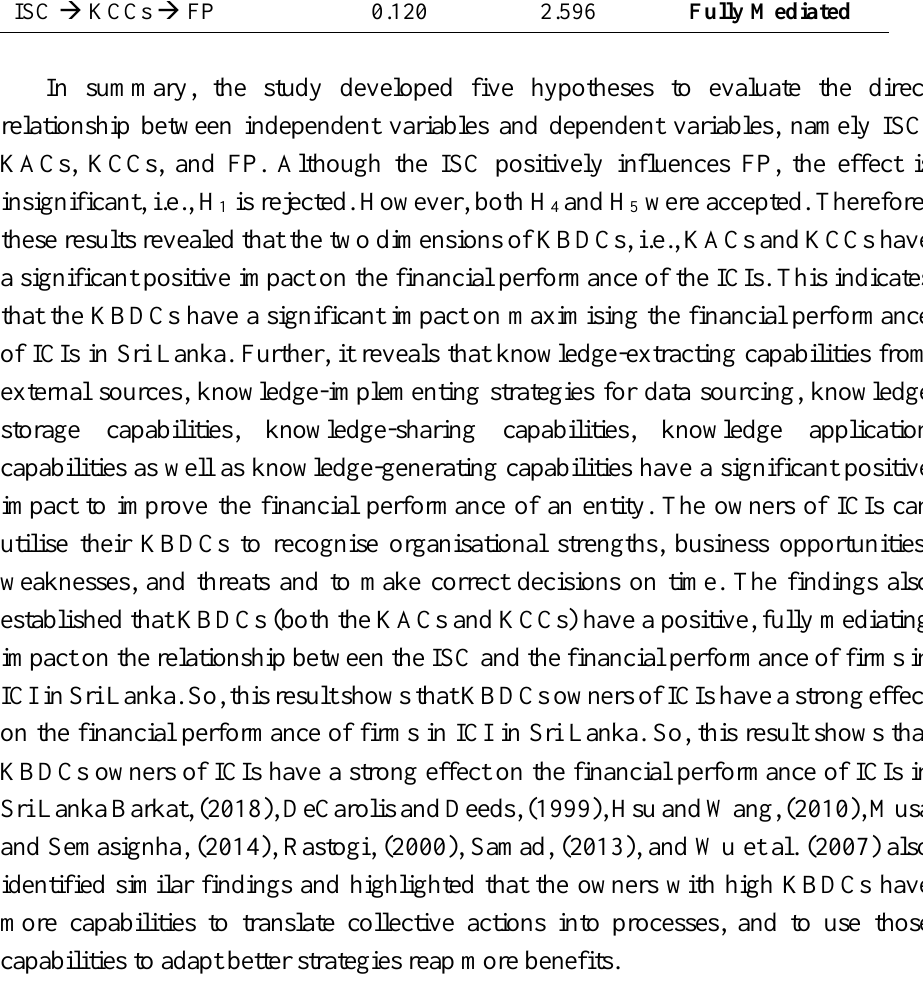
Table 8: Mediating Impact of KACs and KCCs ISC → KACs →